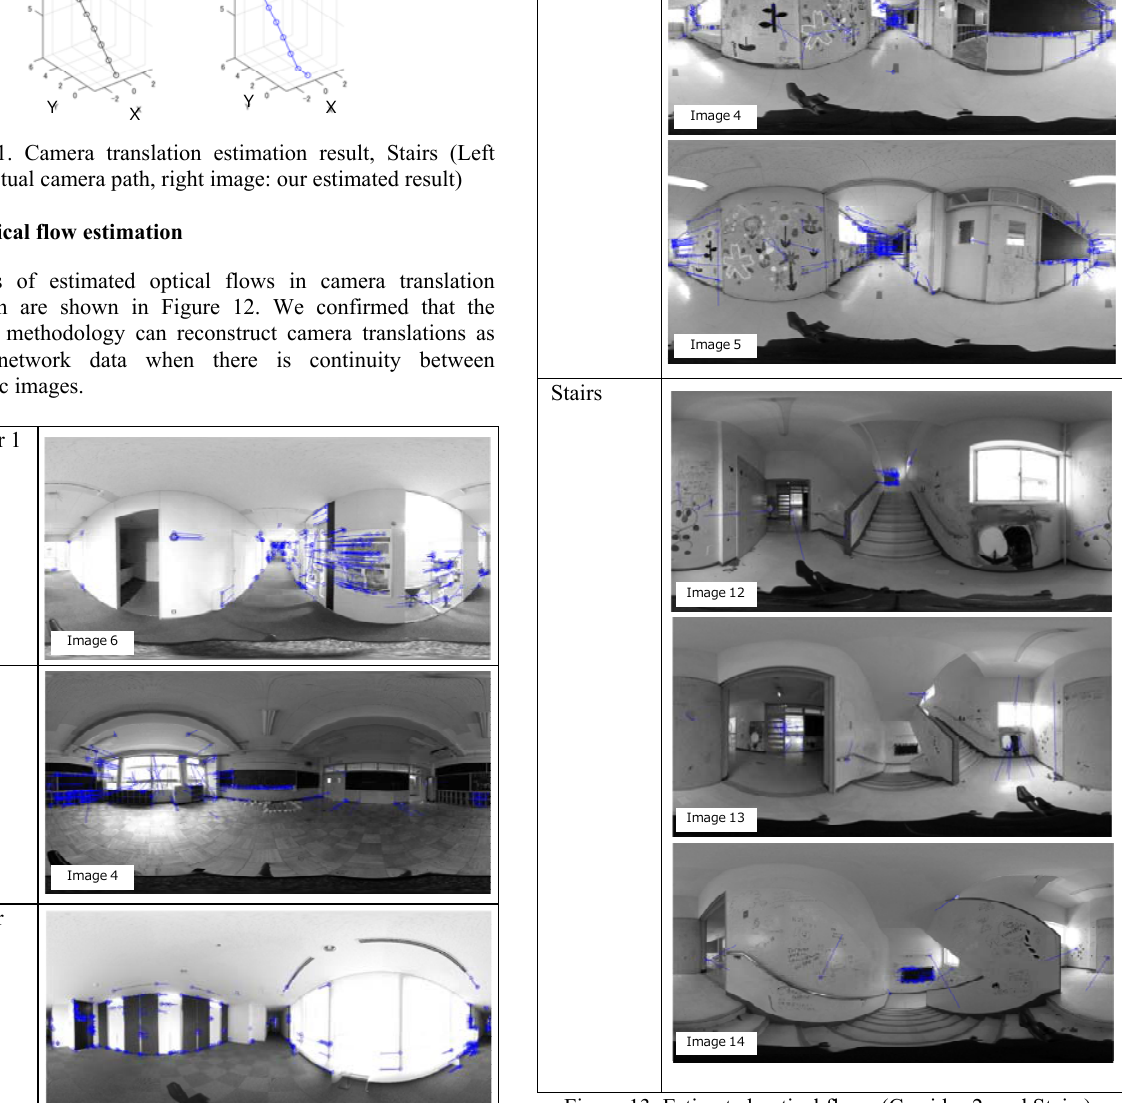
Figure 13. Estimated optical flows (Corridor 2, and